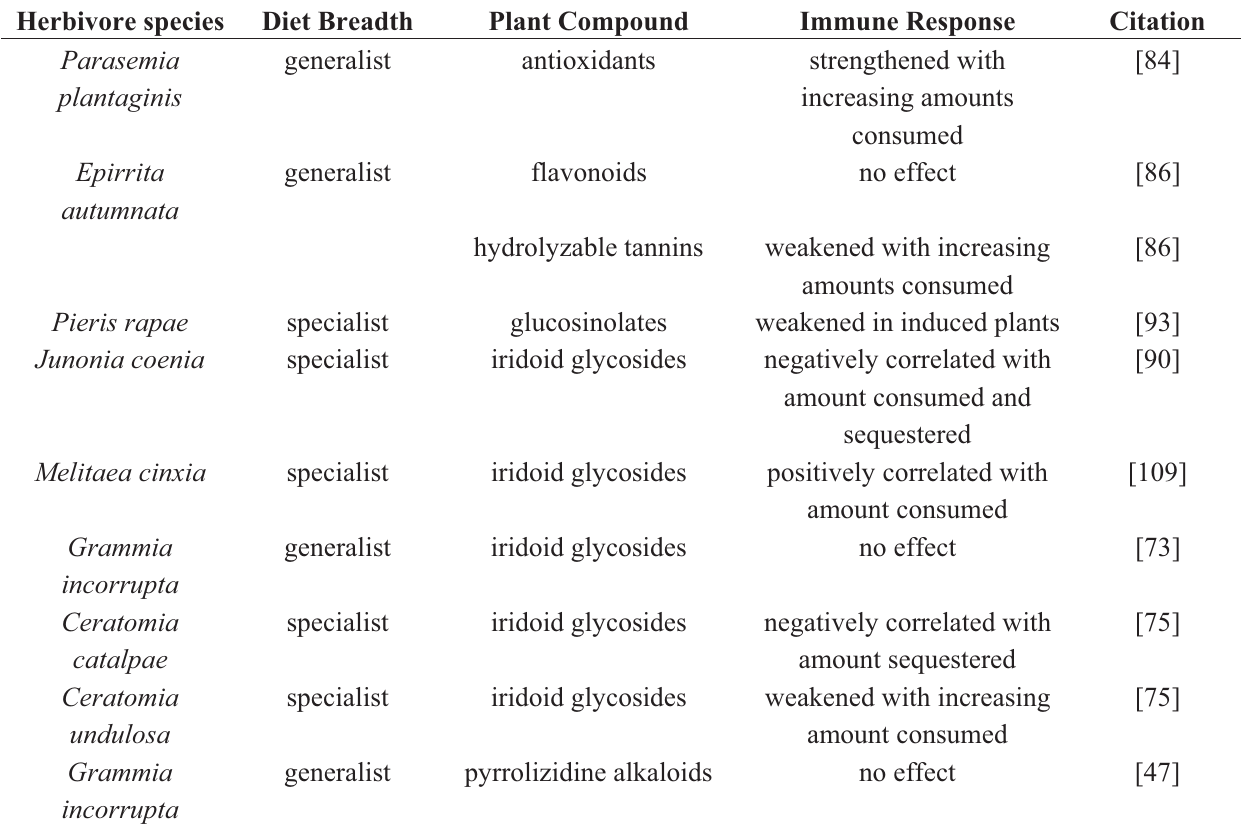
Table 2. Effects of plant secondary metabolites on immune response of specialist and generalist Lepidopteran